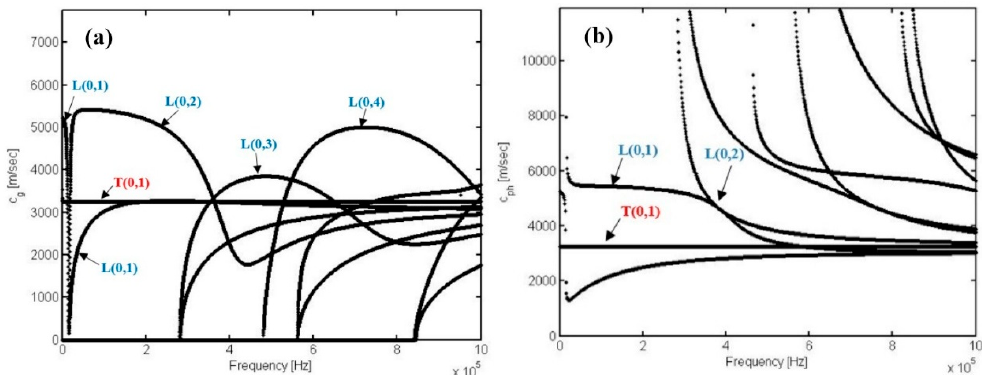
Figure 2. Sample of ( a ) group velocity dispersion curve and ( b ) phased velocity dispersion curve for a 6.5-inch outer diameter (OD) schedule 40 steel pipe with a thickness of 6 mm, including all of the torsional mode T(0,m) and longitudinal mode L(0,m), i.e., (m = 1,2,3, . . . ), and non-axisymmetric modes of all T(n,m) and L(n,m), i.e., (n = 1,2,3, . . . ,m = 1,2,3, . . . ) [100].